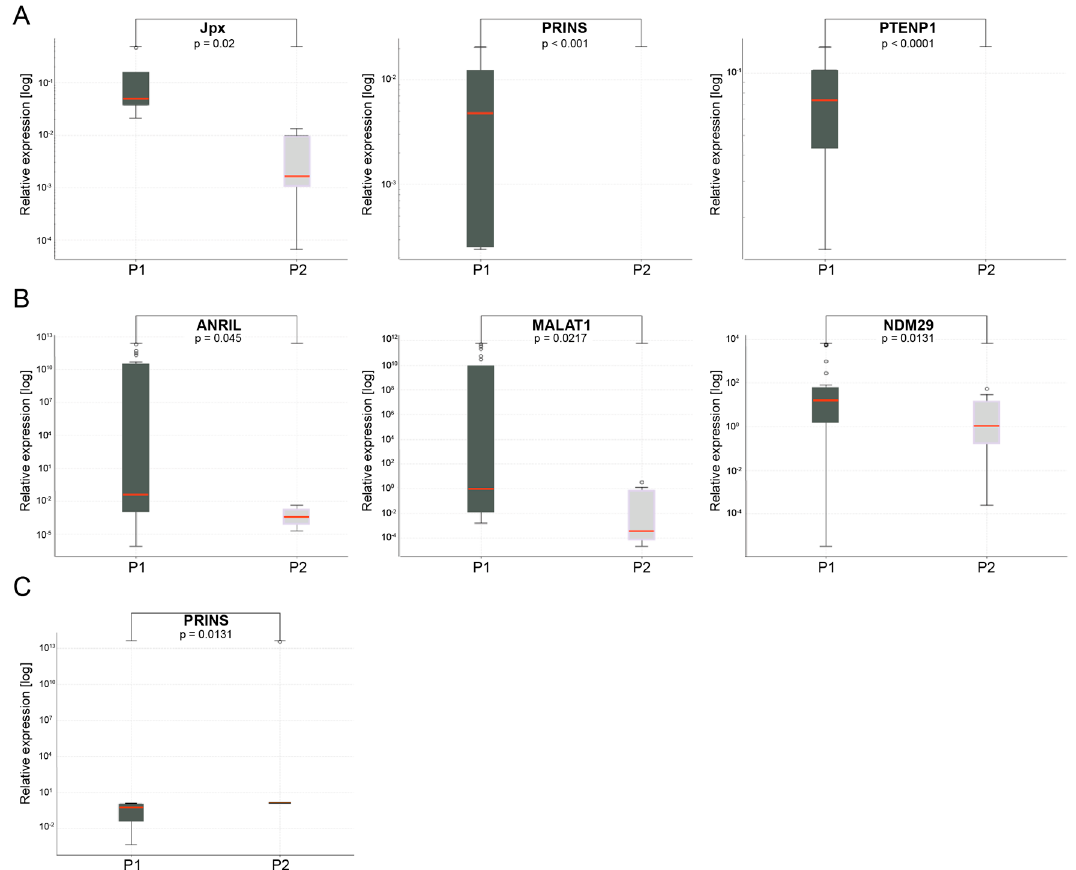
Figure 6. lncRNA expression in palliative group with ( A ) disease control rate (DCR) and ( B ) progressive disease (PD) response, and ( C ) in a locally advanced group, depending on two time points—before chemotherapy (P1) and after three cycles of chemotherapy (P2). Data present median expression of lncRNA with confidence interval (CI); p < 0.05.